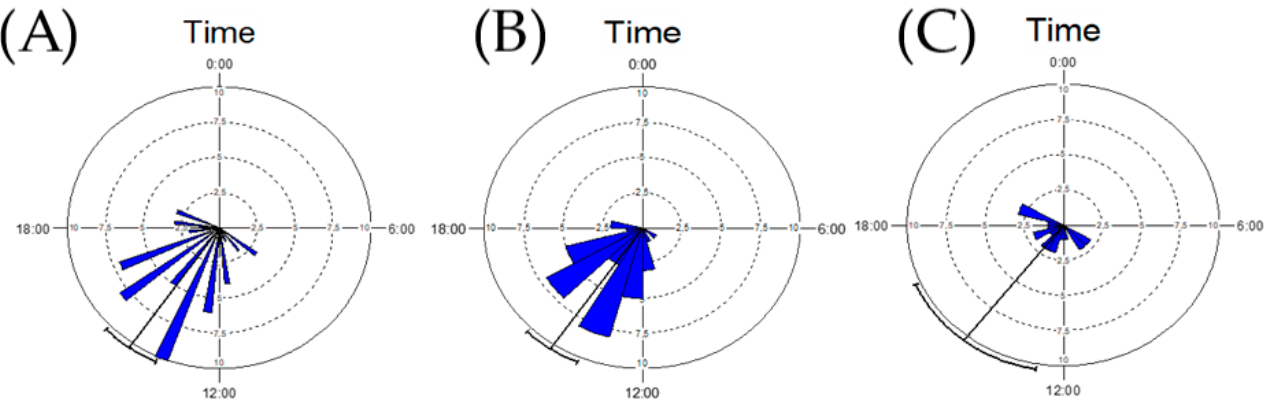
Figure 4. The flight activity by sex: both sexes ( A ), females ( B ), and males ( C ). Peaks of flight activity are indicated with a confidence interval of 95% .